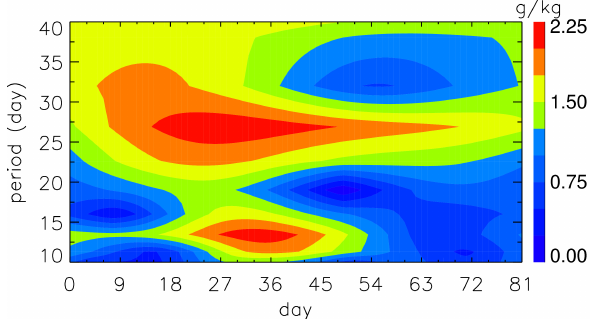
Figure 14. Wavelet spectrum of specific humidity at 150 ◦ E (aver- aged over 5–20 ◦ N) from NCEP/NCAR reanalysis